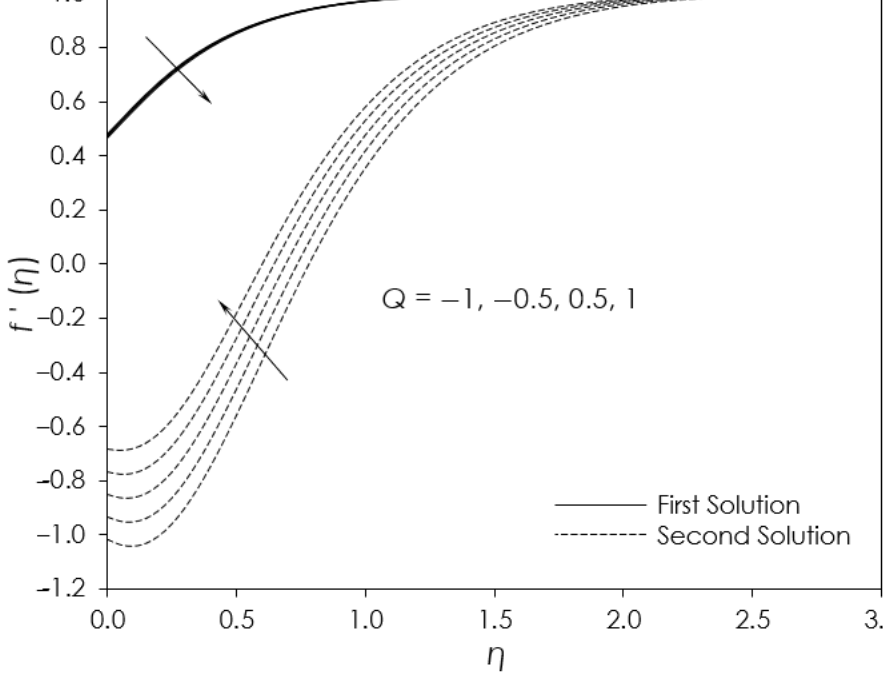
Figure 9. Variation of 𝑓′(𝜂) for different values of 𝑄 .